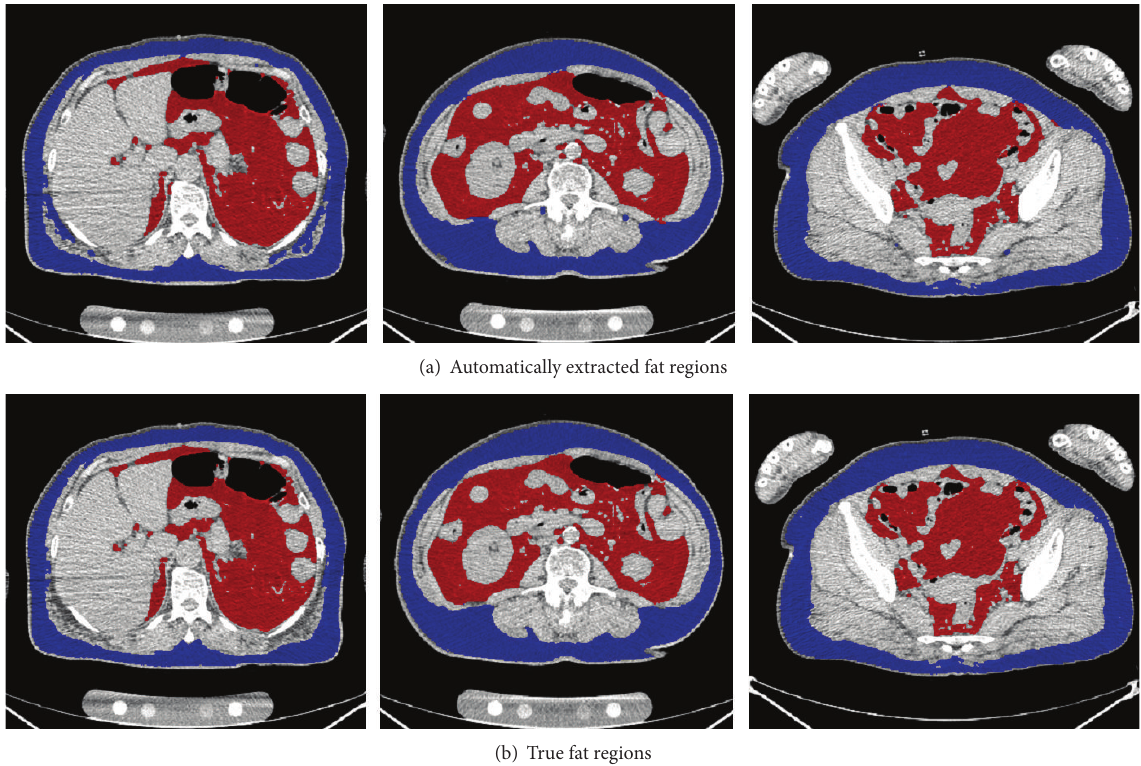
Figure 2: Example of successful automatic extraction of fat regions. Red/blue regions are visceral/subcutaneous fat regions.